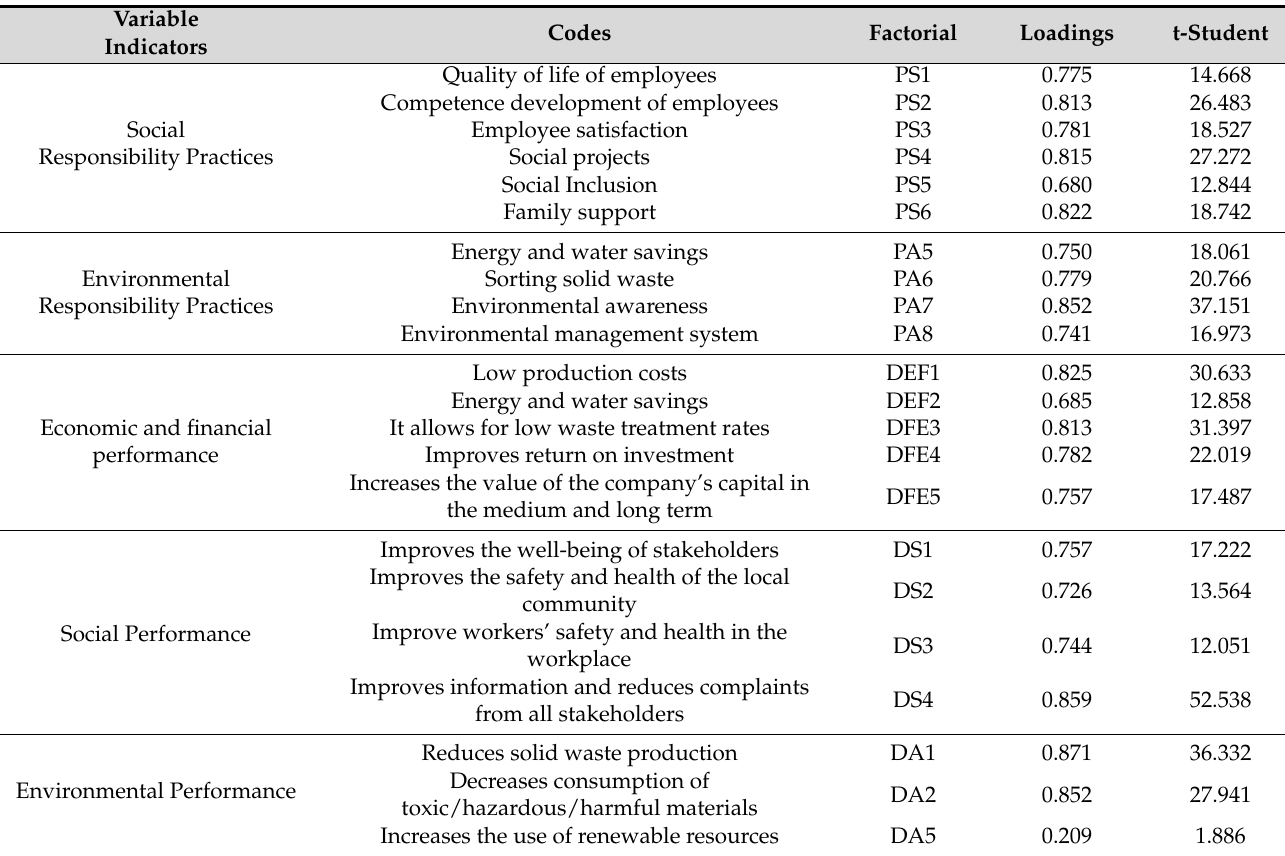
Table A1. Survey indicators factorial